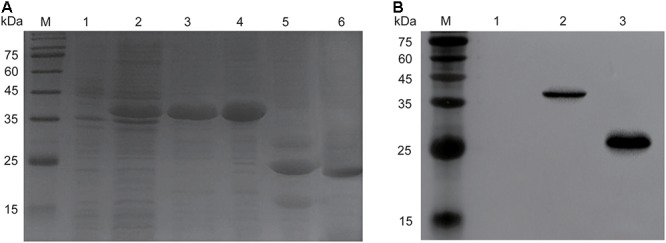
Over expression and purification of endolysin Ply6A3. (A) Lane M, molecular weight marker; Lane 1, un-induced bacterial lysate; Lane 2, IPTG-induced bacterial lysate; Lane 3, purified His-SUMO-Ply6A3 protein; Lane 4, dialyzed His-SUMO-Ply6A3 protein; Lane 5, Ply6A3 protein after cleavage of the His-SUMO tag; Lane 6, purified endolysin Ply6A3 protein after cleavage and dialyze of the His-SUMO tag. (B) Lane M, molecular weight marker; Lane 1 un-induced bacterial lysate; Lane 2-4, IPTG-induced bacterial lysate; Lane 5, the His-SUMO tag cleaved from endolysin Ply6A3. Ply6A3, the endolysin encoded by a novel Acinetobacter baumannii Phage PD6A3 gene. IPTG, Isopropyl β-D-Thiogalactoside.